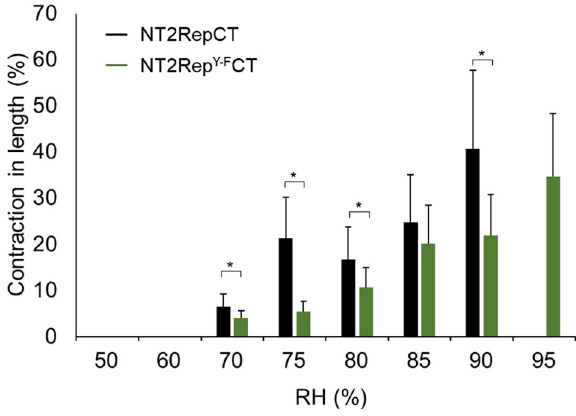
Fig. 2 Supercontraction in response to different relative humidities. Contraction in length of the fi bers when exposed to relative humidity (RH) for 2 h. No contraction was detected at relative humidity < 70% for both the constructs. At 95% the NT2RepCT dissolved, but the NT2Rep Y-F CT did not. Asterisks above the histograms indicate signi fi cant differences ( p value <0.05). Black color is used for NT2RepCT fi bers and green color for NT2Rep Y-F CT fi bers. The error bars are the standard deviation of the data